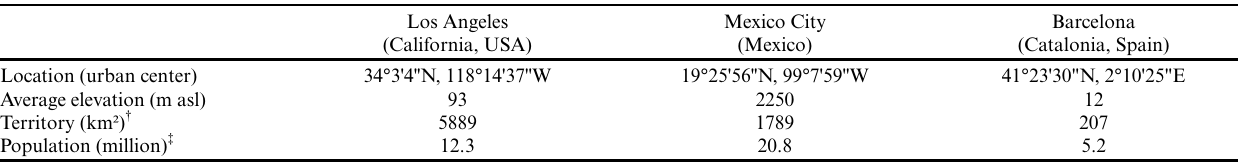
Table 1 . Geographical and population traits for the three studied urban-agricultural